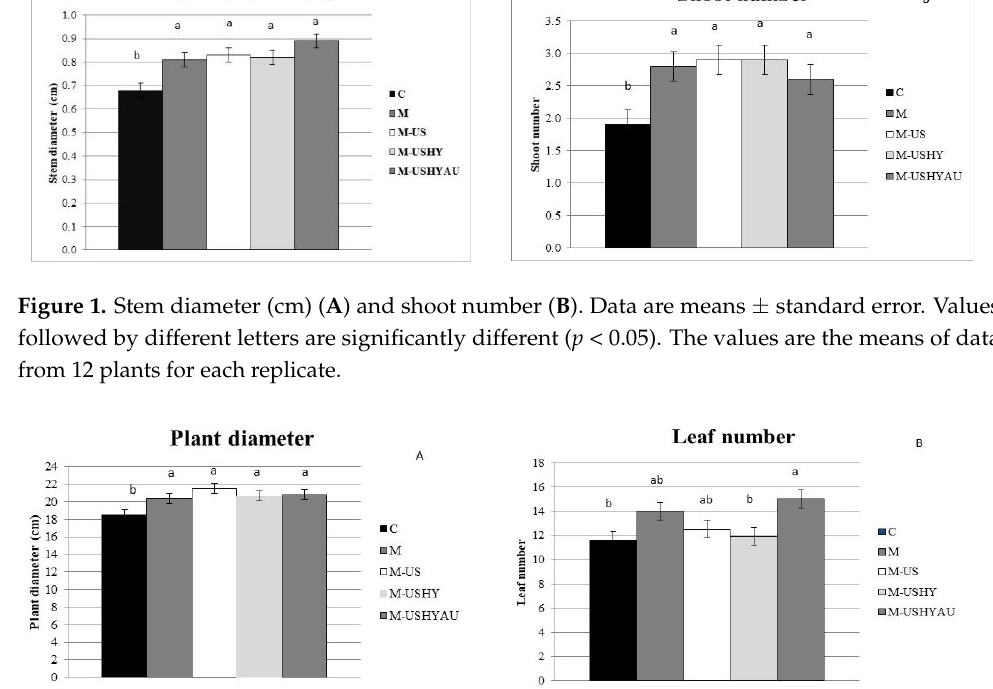
Figure 2. Plant diameter (cm) ( A ) and number of leaves ( B ). Data are means ± standard error. Values followed by different letters are significantly different ( p ˂ 0.05). The values are the means of data from 12 plants for each replicate.